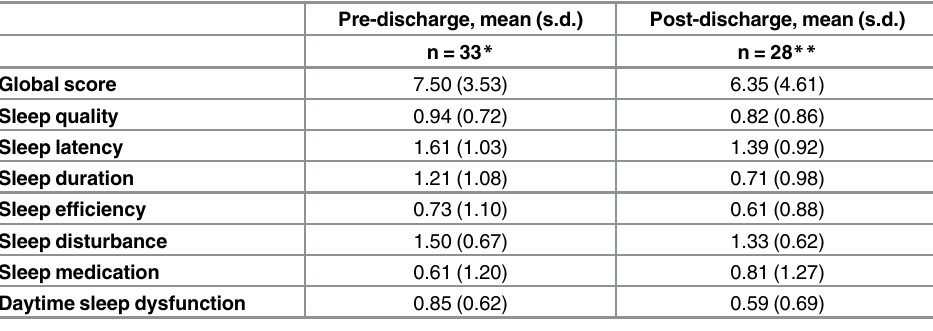
Table 2. Pittsburgh Sleep Quality Index (PSQI)